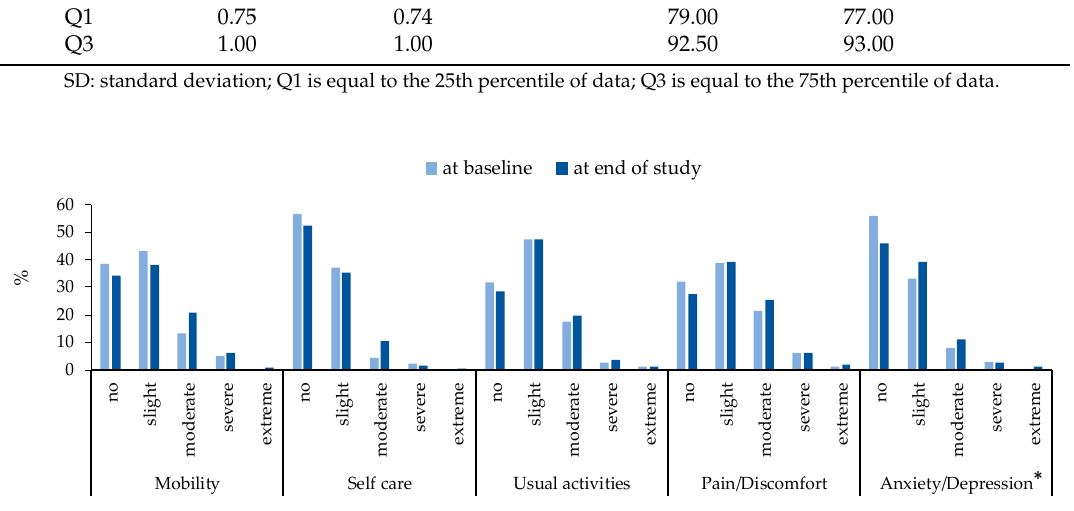
Figure 3. Changes of EQ-5D-5L from baseline to end of study for people with Parkinson’s ( n = 301). * means significant difference ( p < 0.05) among different level of anxiety/depression. Table 4. The mean differences of EQ-5D-5L values and EQ VAS scores between people with Parkinson’s and non-Parkinson’s: Results from linear mixed model analysis ( n = 563).